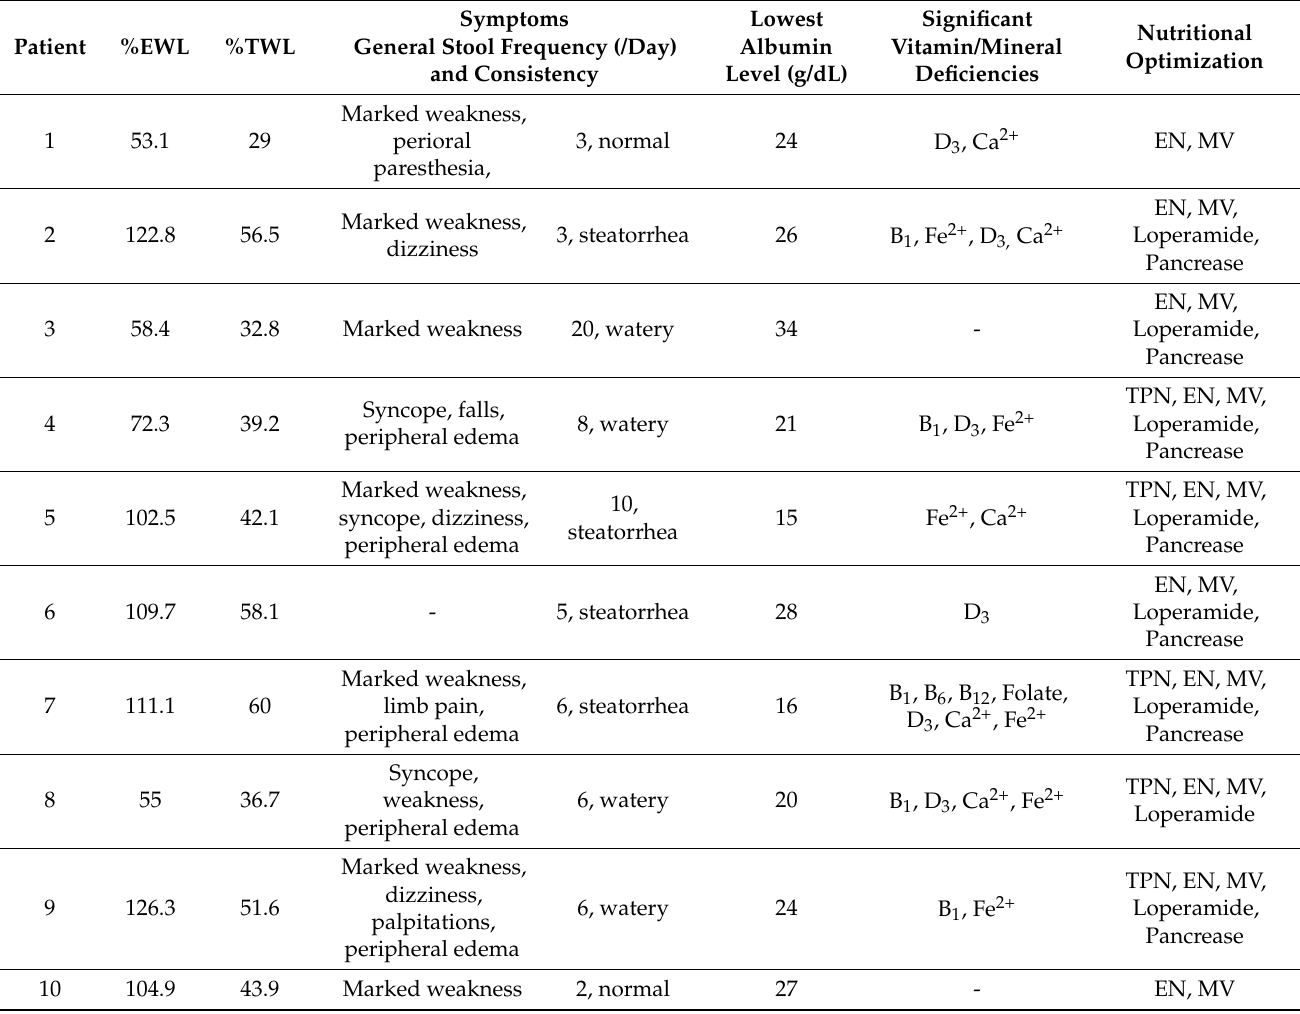
Table 2. Preoperative characteristic of OAGB patients with severe